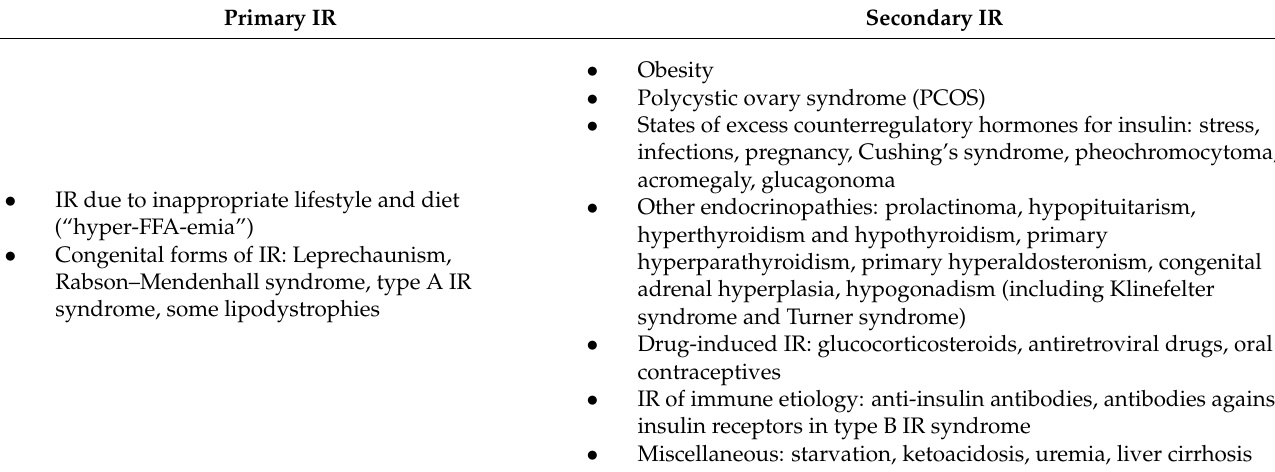
Table 1. Types and causes of